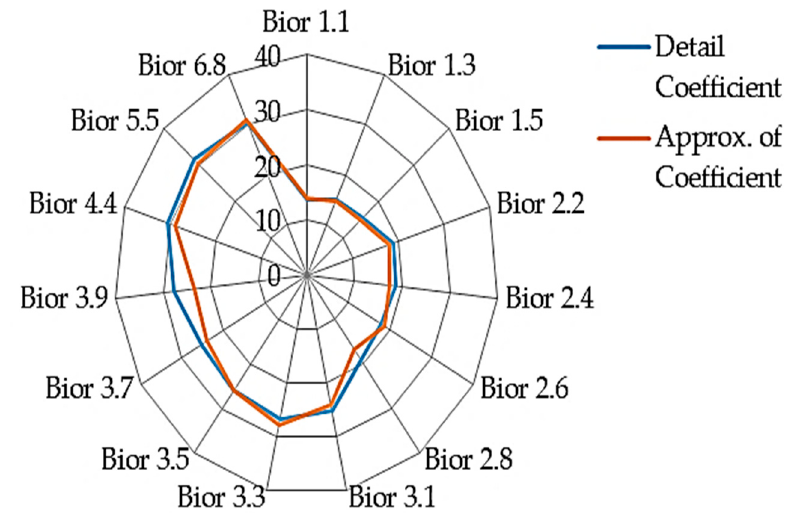
Figure 14. Comparison of the performance of detail and approximation coefficient feature classification.